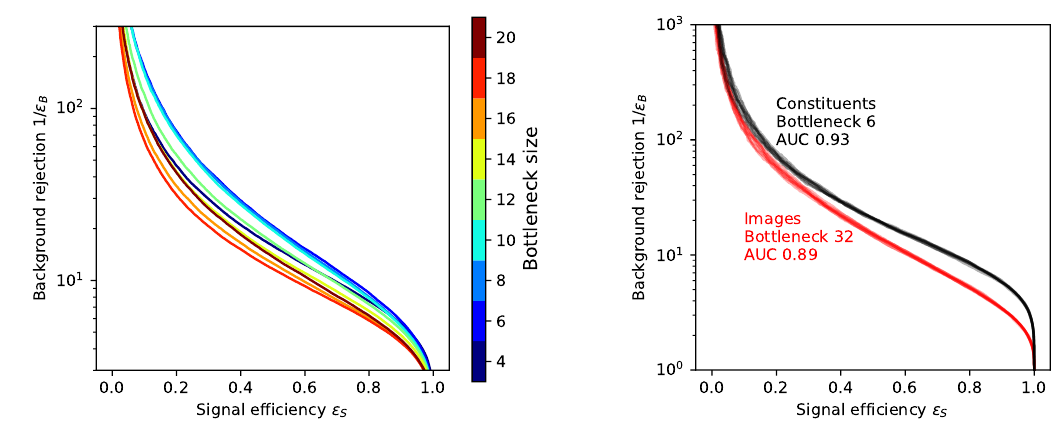
Figure 4: Left: ROC curves for the 4-vector-based or L O L A autoencoder identifying anomalous top jets for different bottleneck sizes. Right: comparison of the ROC curves for the image-based and the 4-vector-based autoencoders. The widths of the lines show the variation based on ten independent test samples for fixed